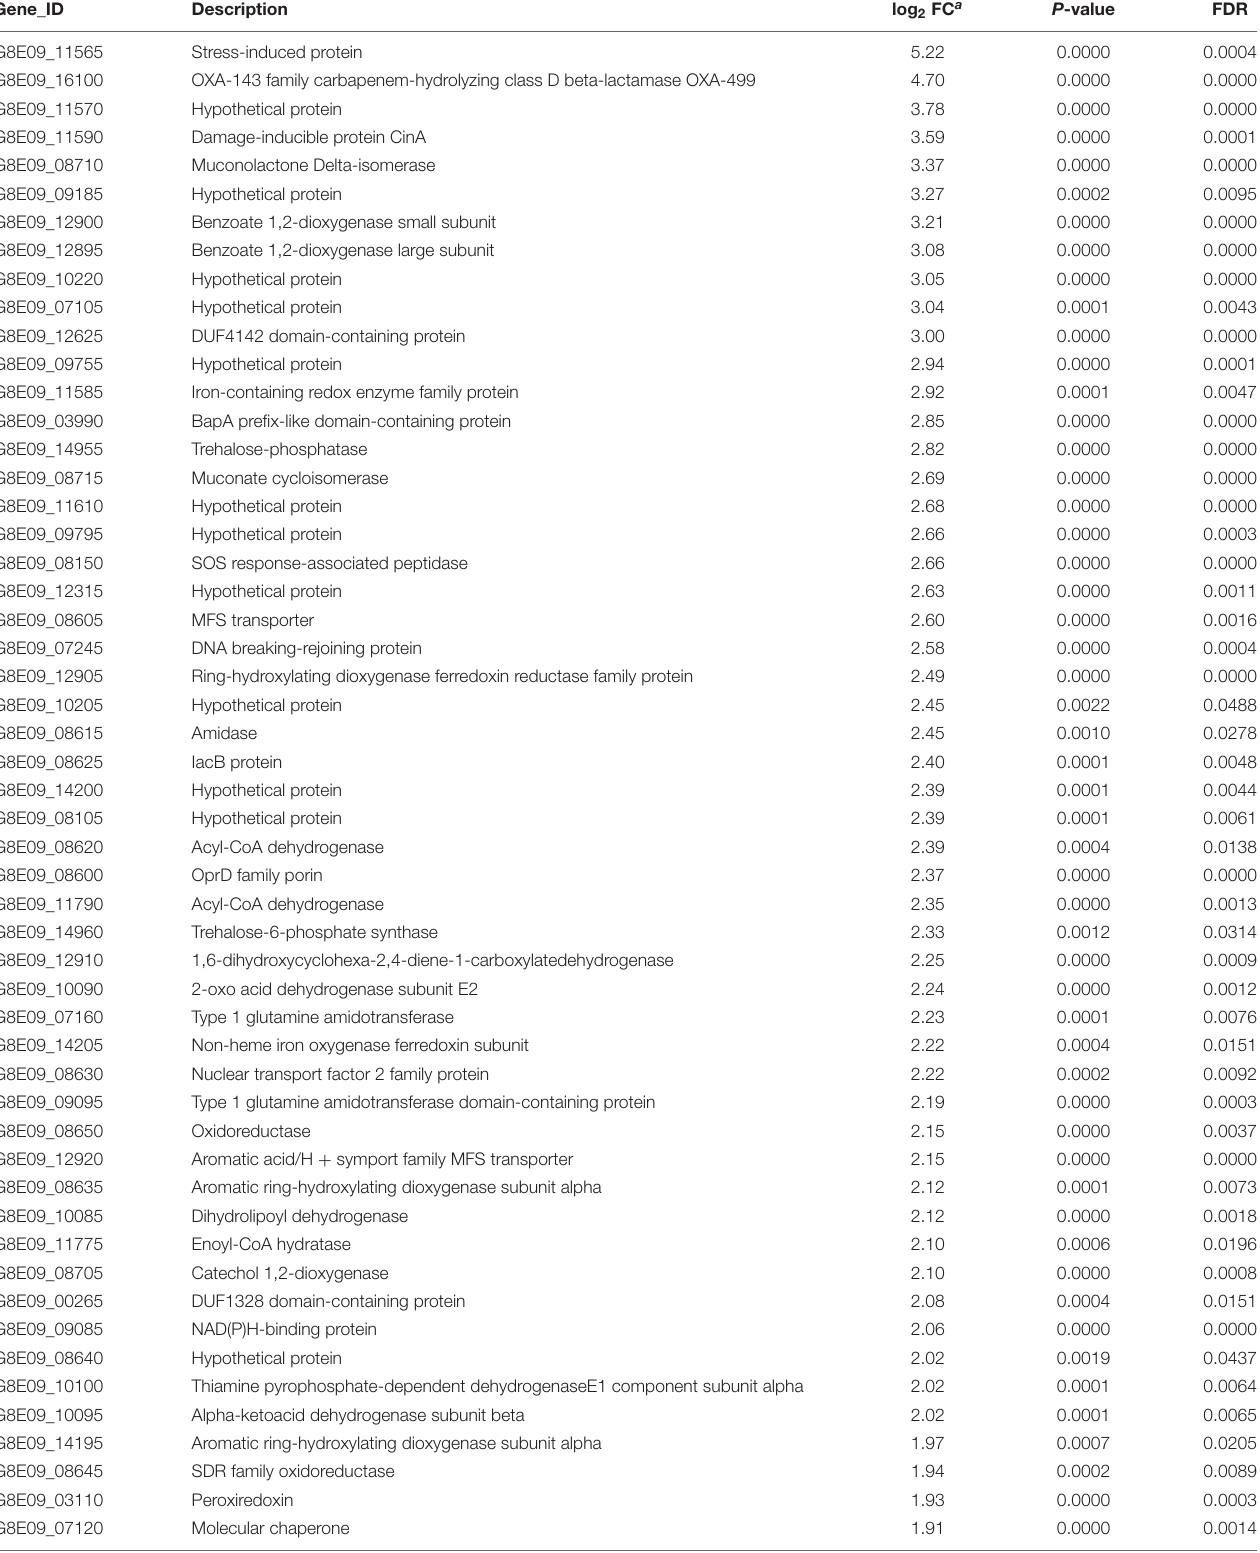
TABLE 3 | Differentially expressed genes in CAB009 compared with